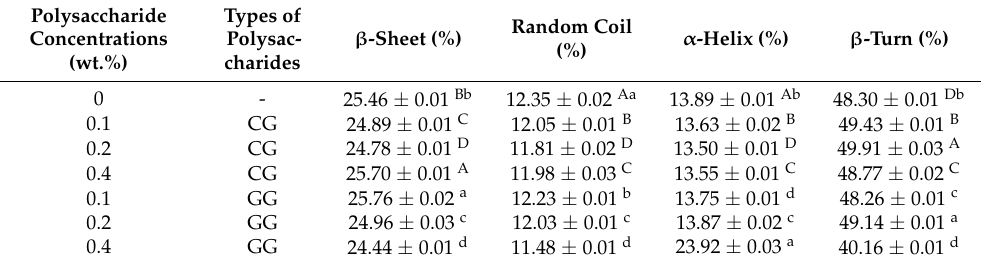
Results are presented as mean values ± standard deviation of three replicates. Different upper case letters indicate significant differences among different additions of CG ( p < 0.05). Different lower case letters indicate significant differences among different additions of GG ( p <